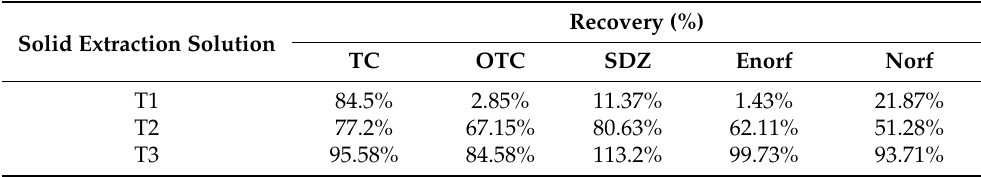
Table 3. Comparison between three different solid extraction methods of 5 combined antibiotics recovery from swine manure.